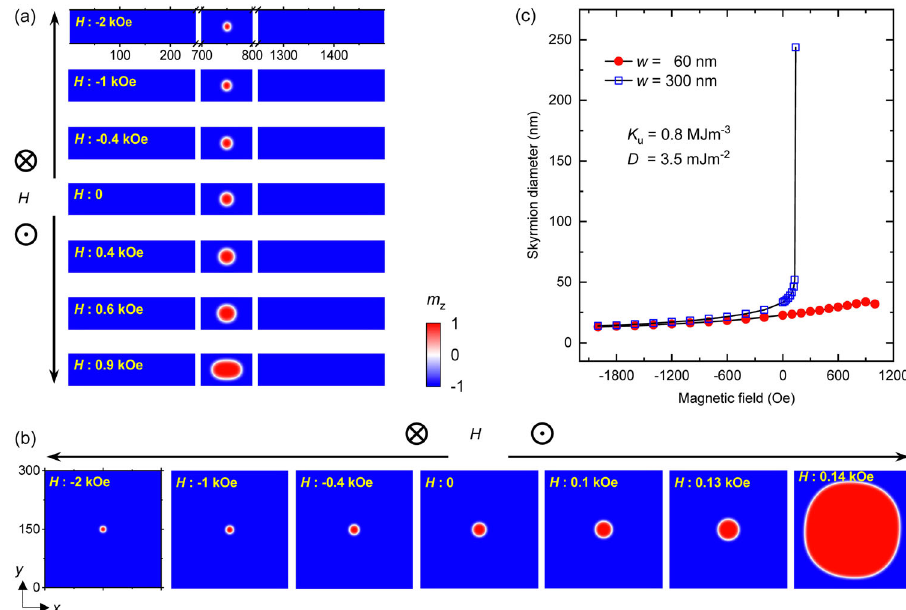
Fig. 1 Isolated skyrmion ’ s response to a uniform perpendicular magnetic fi eld. a , b Equilibrium spin con fi gurations of an isolated skyrmion in a magnetic nanotrack (width w = 60 nm, length l = 2000 nm) and square nanoelement ( w = 300 nm) under different magnetic fi elds. Field strength H is indicated on each panel. Determined by the fi eld polarity, the skyrmion either expands or contracts without a net displacement. The color scale for m z , the perpendicular magnetization component, is used throughout this paper. c Skyrmion size as function of fi eld strength. Lines are guides to eyes. Strong edge con fi nement in the nanotrack suppresses expansion of skyrmion area. The strengths of perpendicular magnetic anisotropy and Dzyaloshinskii-Moriya interaction are K = 0.8 MJm − 3 and D = 3.5 mJm − 2 , u